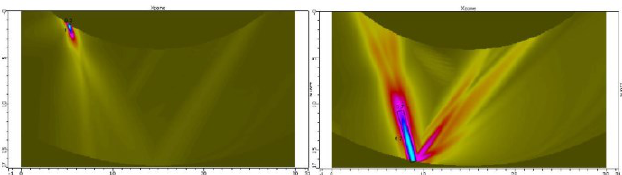
Fig. 11. Beam profiles: 2 MHz, 7x7mm rectangular probe, spherical focus r=10 mm (left) and 200 mm (right).